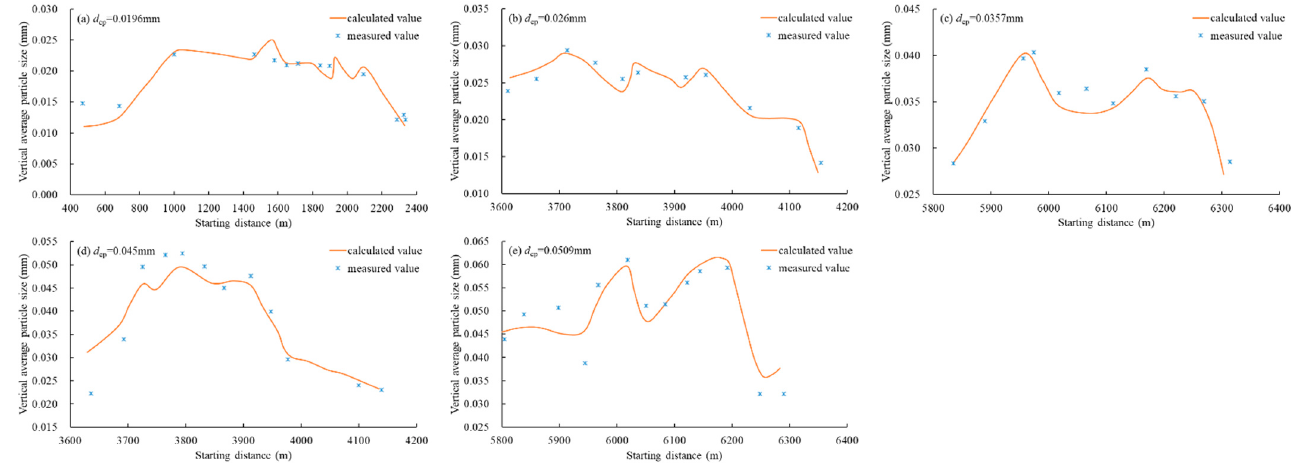
Figure 5. Verification of Formula (16) with different suspended sand particle size data: ( a ) d cp = 0.0196 mm; ( b ) d cp = 0.026 mm; ( c ) d cp = 0.0357 mm; ( d ) d cp = 0.045 mm; and ( e ) d cp = 0.0509 mm.